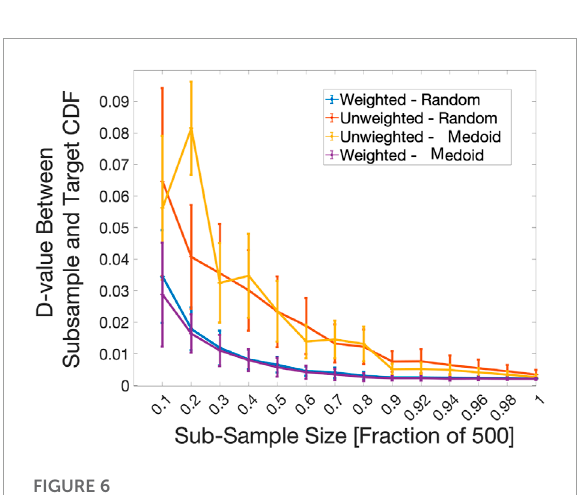
FIGURE 6 D-value versus sub-sample size trends for the constitutive model. A comparison of the convergence to the target distribution between random sub-sample selection with PLOW applied (Weighted-Random), random sub-sample selection without PLOW (Unweighted-Random), k-medoids sub-sample selection with PLOW applied (Weighted - Medoid), and k-medoids sub-sample selection without PLOW (Unweighted - Medoid) are shown. The sub-sample size represents the number of input points used to construct the proposal distribution. At each X -axis interval, 100 2-Sample K-S statistic values (D-values) were calculated between the target distribution and a proposal distribution constructed using a different drawing of points from the pool of 500 total input points. The average and standard deviation of the 100 D-values is plotted.